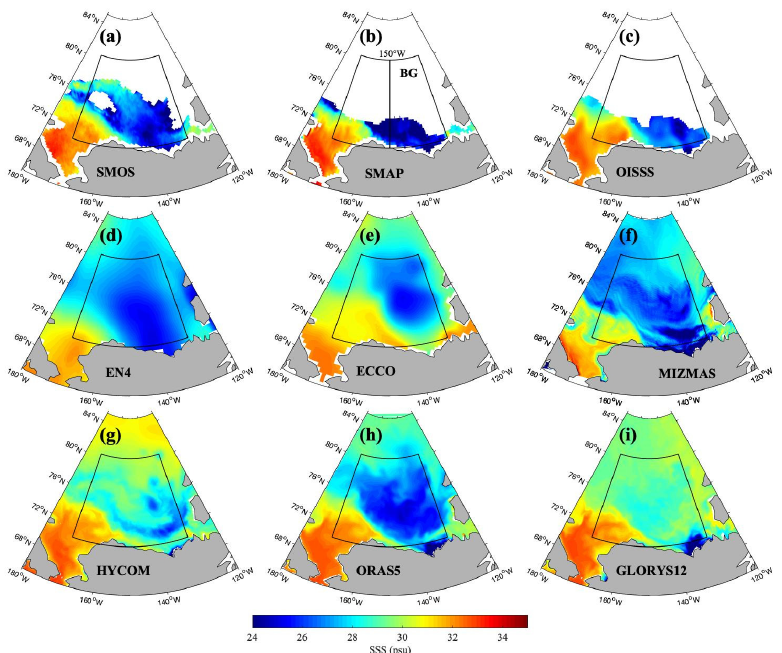
Figure 3. Arctic Ocean sea surface salinity (SSS) averaged over the month of September 2015 in the Beaufort Gyre (BG) region derived from satellites: ( a ) SMOS, ( b ) SMAP, ( c ) OISSS, objective analysis product: ( d ) EN4, and ocean model simulations: ( e ) ECCO, ( f ) MIZMAS, ( g ) HYCOM, ( h ) ORAS5 and ( i ) GLORYS12. 150 ◦ W transect is outlined for comparisons in this study.